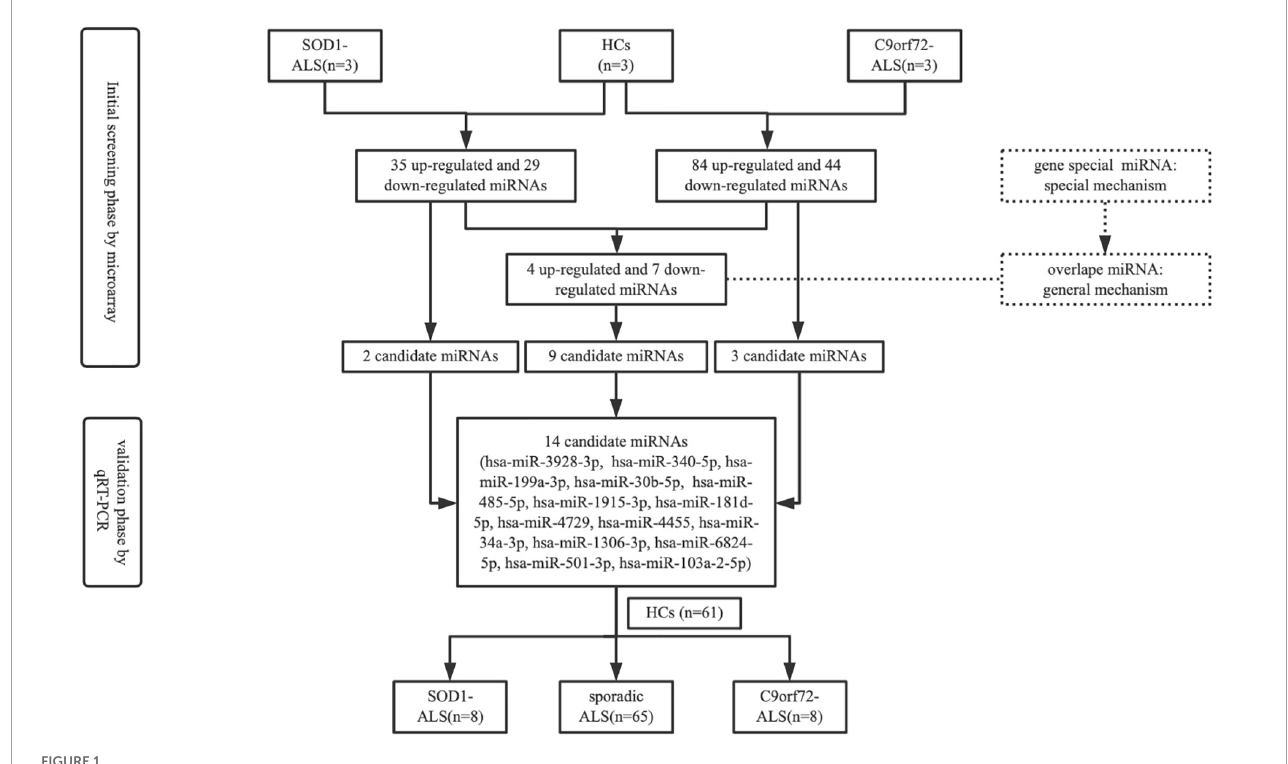
FIGURE1 Schematic diagram illustrating the study